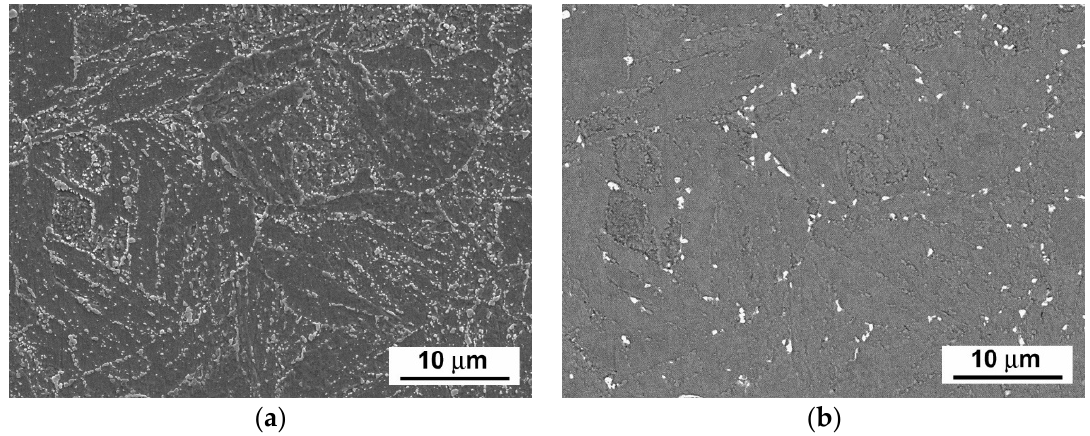
Figure 5. SEM images of investigated P92 steel in thermally aged material condition (600 °C/5 kh) visualized by ( a ) secondary electrons and ( b ) back-scattered electrons.